Question: Is the quantity shown trending increasing or decreasing?
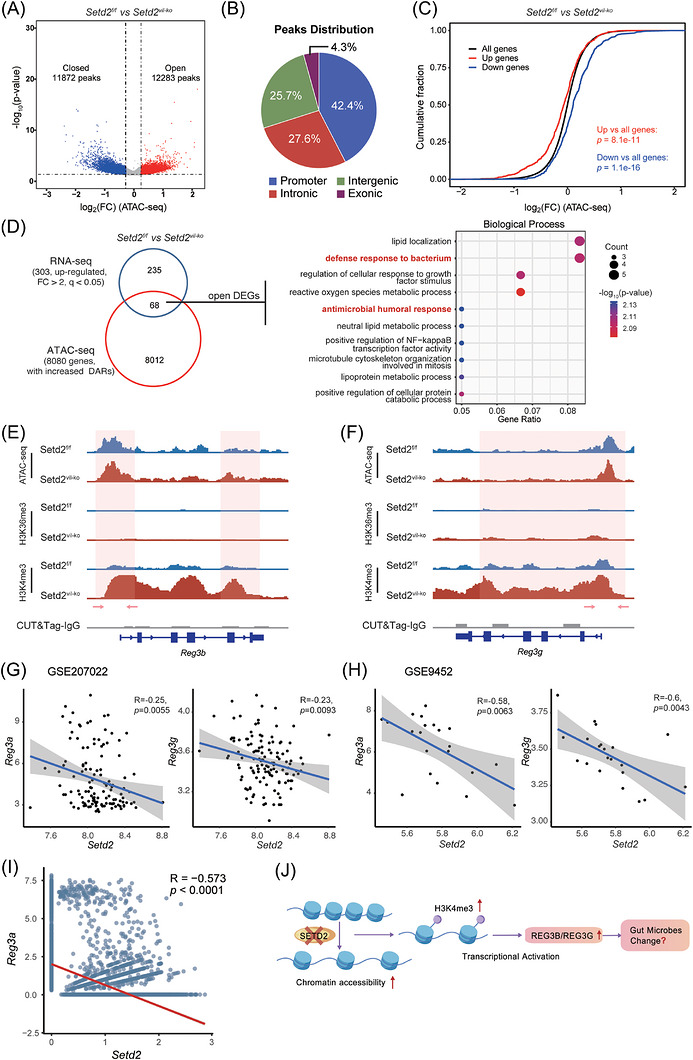
Answer: increasing